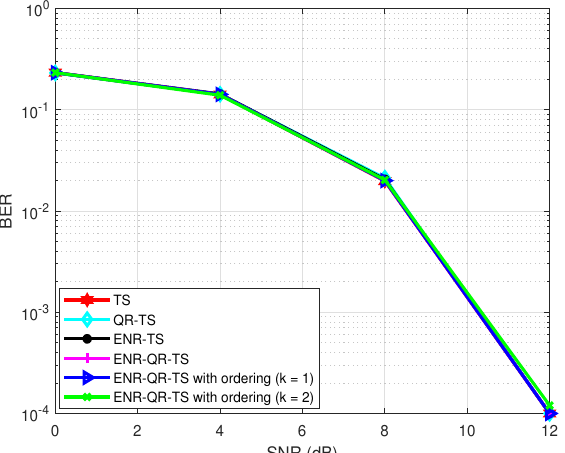
Figure 3. Comparison of the BER performance of TS algorithms for a 32 × 32 MIMO system with 4-QAM.